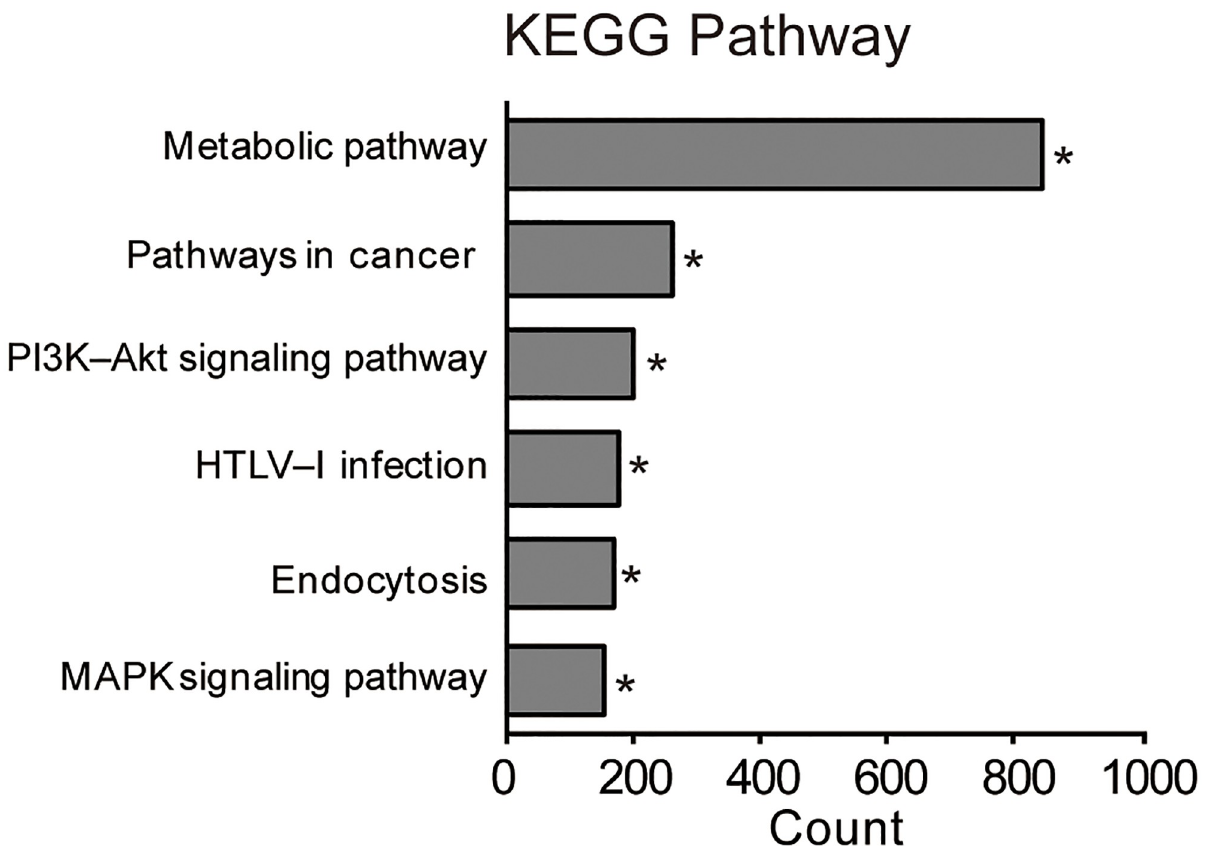
Fig 3. KEGG pathway analysis on the mRNA profile of exosome-like vesicles. The top six pathways are shown. For each pathway, bar plots show the counts of genes that belong to the pathway. Asterisk denotes the biological significance (P < 0.05).